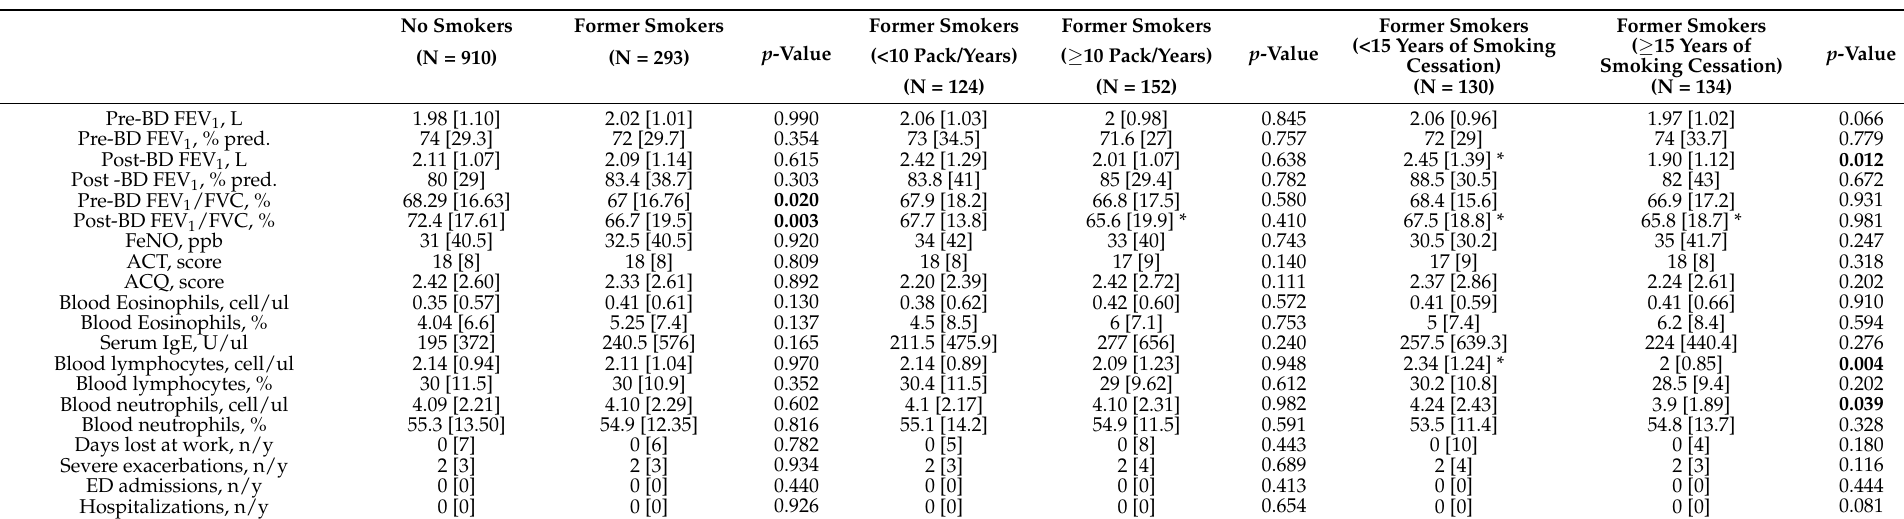
Data are shown as numbers of patients (percentage) or medians [interquartile range]. Percentages are calculated for non-missing data. Abbreviations: BD indicates bronchodilator;